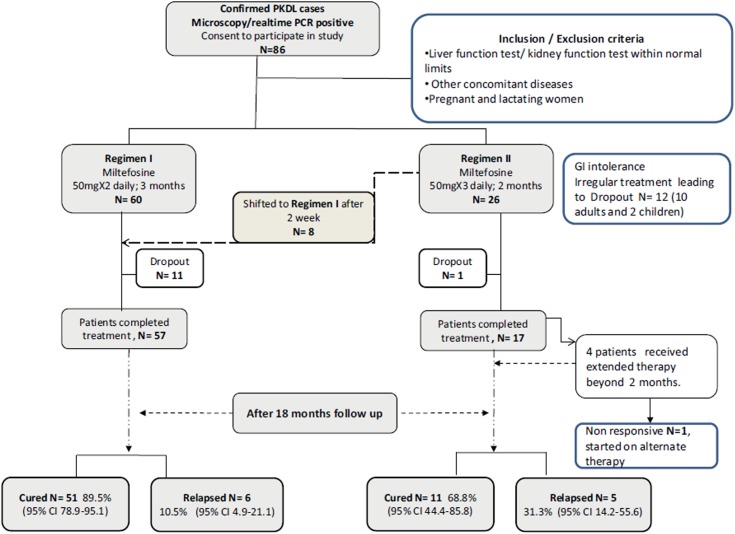
Recruitment, treatment and follow-up of PKDL patients.